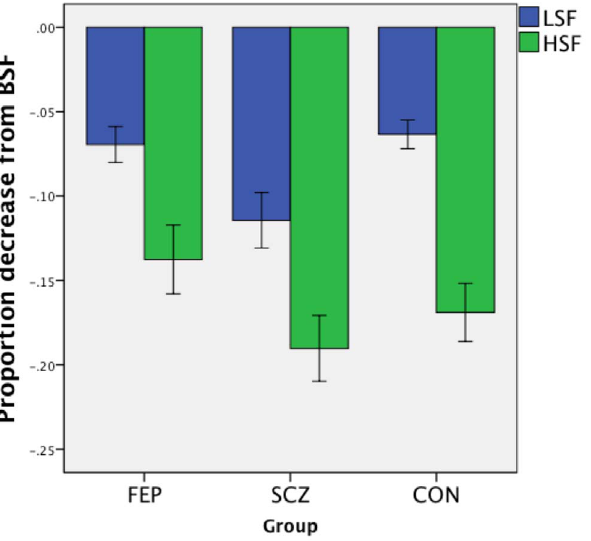
Fig. 3. Performance decrement from BSF, in LSF and HSF conditions, for each group, at Time 2. Error bars reflect + / 2 1